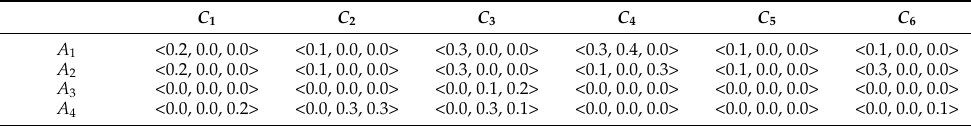
Table 5. The SVNPDA.